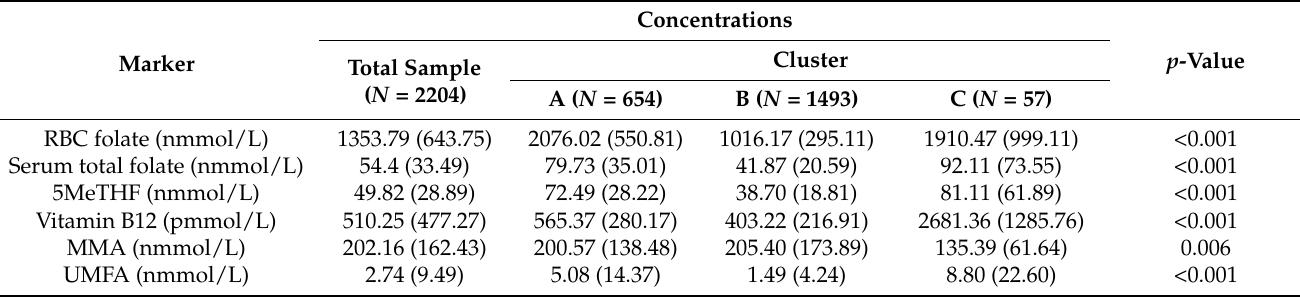
Figure 2. The characterization of cognitive performance in different clusters of older adults. Distri- bution of RBC folate, serum total folate, 5MeTHF, and vitamin B12 concentrations in the NHANES cohort for each cluster (Cluster A: red, Cluster B: green, Cluster C: blue). Table 2. Mean (SD) concentrations of markers representing folate and vitamin B12 status of US older adults (≥ 60 y; n = 2204) from the 2011 – 2014 NHANES cohort.